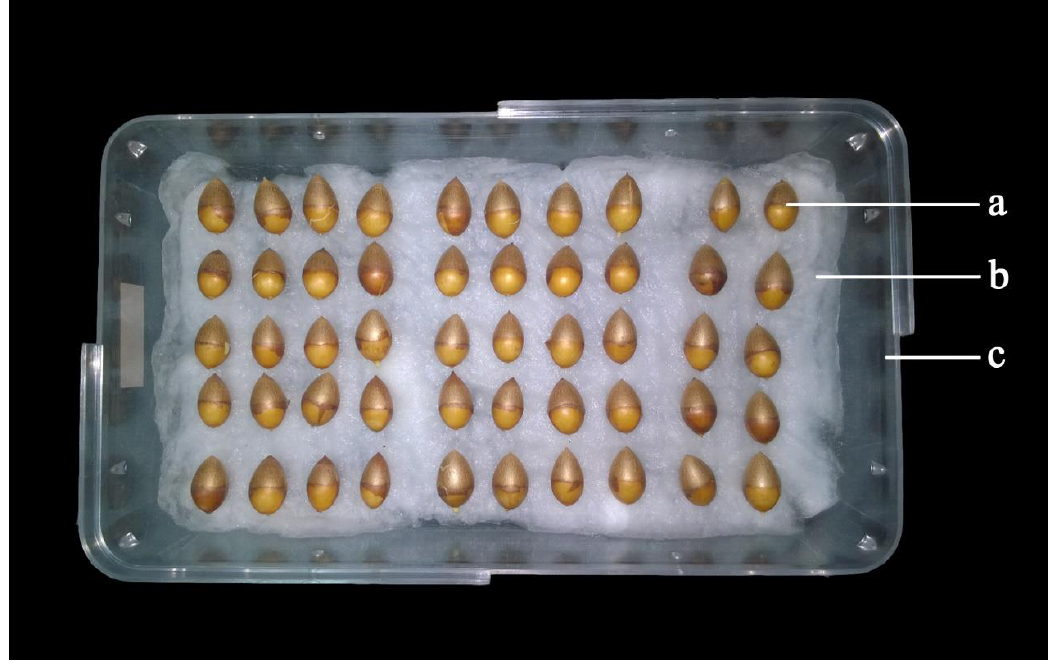
Figure 1. Germination test of G. biloba seeds during desiccation. ( a ) De-coated seed; ( b ) cotton with deionized water; ( c ) plastic germination boxes (cover not shown).